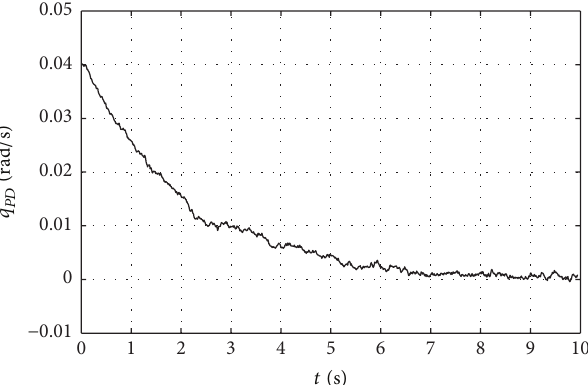
Figure 8: The LOS angular rate of noncooperative